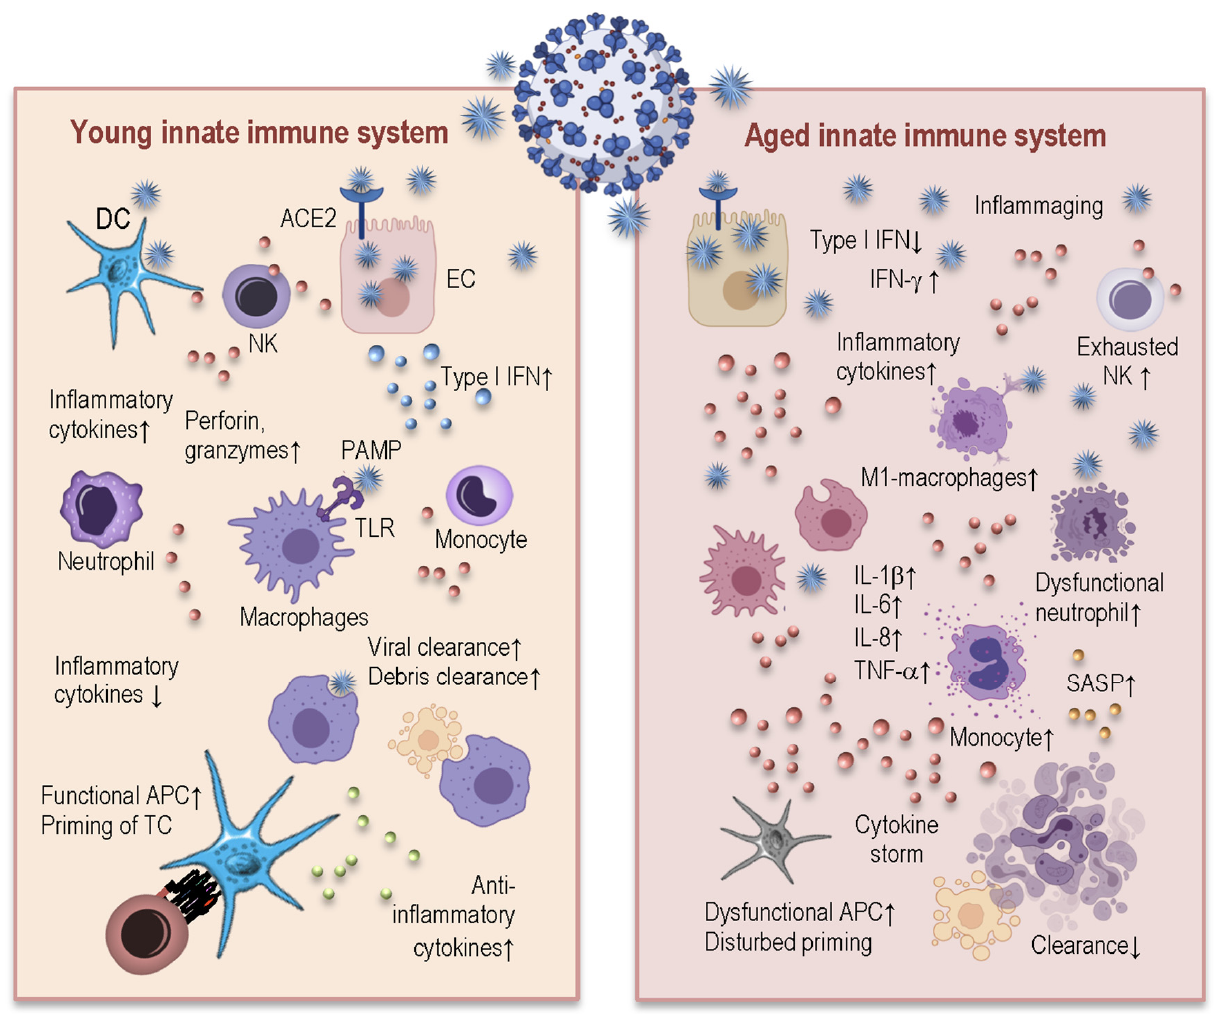
Figure 3. Age-related changes in the innate immune system and their impacts on SARS-CoV-2 infection. The SARS-CoV-2 virus enters endothelial cells by binding to the ACE2 receptor. Once in the host cell ( left ), the virus can be detected by DC, monocytes, and macrophages, inducing local inflammatory and antiviral type I IFN responses that inhibit viral replication and activate and recruit immune cells. The functional APCs of young individuals prime an adaptive immune response, NK cells kill infected cells, and neutrophils clear the cell debris. The innate cells of elderly people ( right ) show impaired functions and the inability to launch a robust type I IFN-response to control virus replication. The inflammaging and SASP attract further dysfunctional inflammatory monocytes, macrophages, and neutrophils to the sites of infection, contributing to the increased local production of cytokines, or “cytokine storm,” and establish an inflammatory feedback loop. These detrimental conditions disturb effective T-cell priming and prevent efficient debris clearance. DC: dendritic cell; NK: natural killer cell; EC: endothelial cell; ACE2: angiotensin-converting enzyme 2; IFN: interferon; PAMP: pathogen-associated molecular pattern; TLR: toll-like receptor; IL: interleukin; TCR: T-cell receptor; SASP: senescence-associated secretory phenotype; APC: antigen-presenting cell; TNF: tumor necrosis factor.